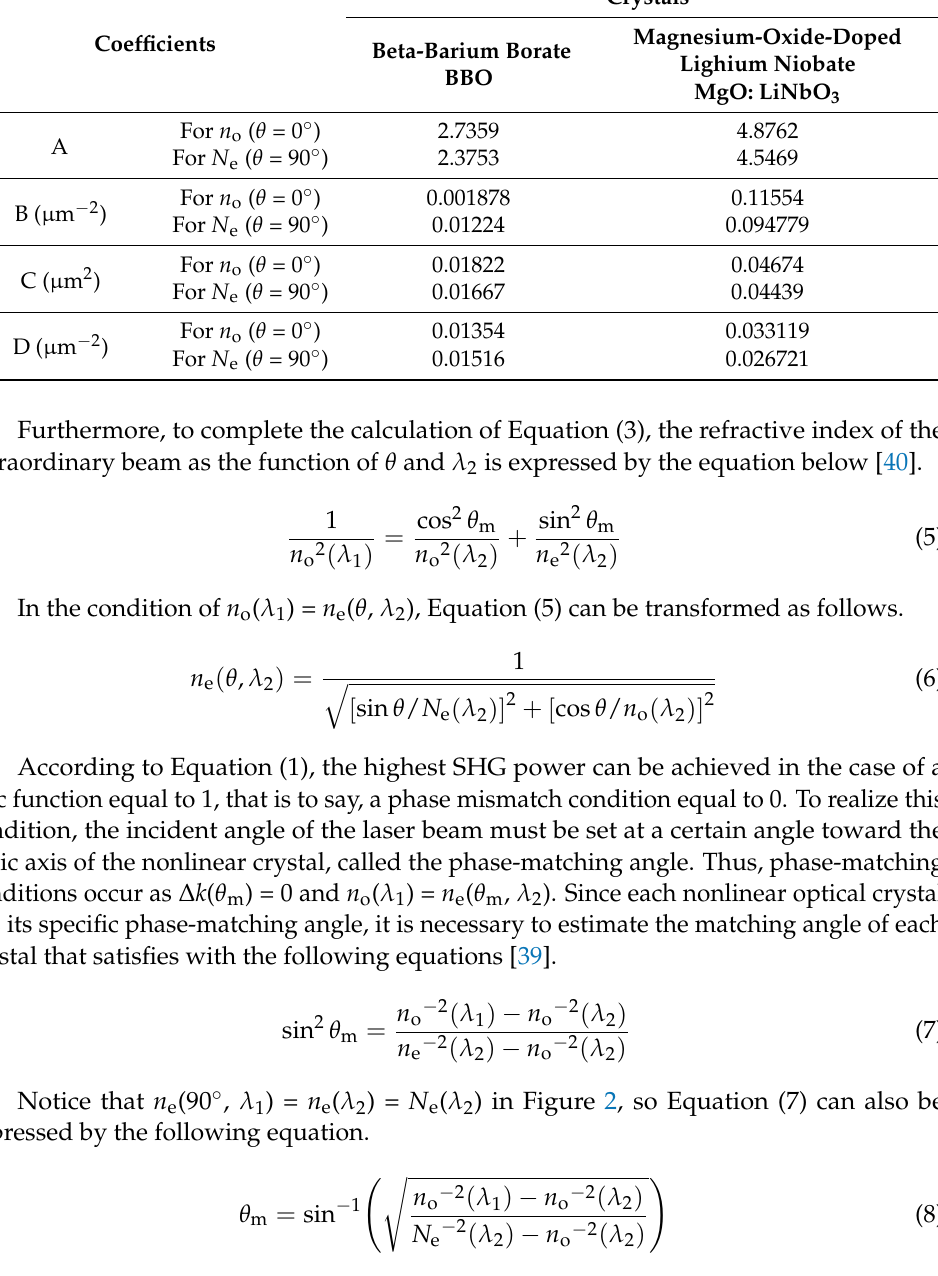
Table 1. Medium-specific constants as the parameters for the empirical calculation of refractive indices [28,41]. Coefficients A